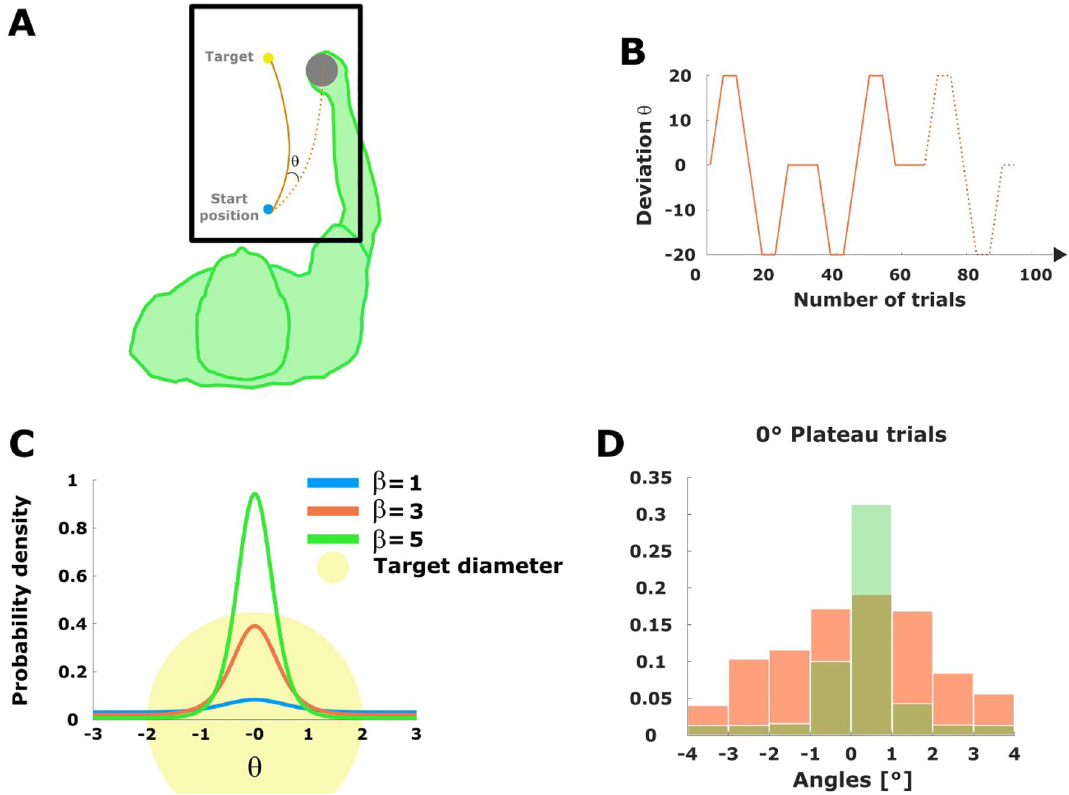
Figure 1. ( A ) Schematic representation of an experimental trial with deviation angle θ . The dotted line represents the participant’s hand movement and the continuous line represents the rotated movement observed on the screen. ( B ) Experimental protocol. The continuous line represents the deviation angles θ imposed during one experimental cycle, where trials 1 to 25 constitute the forward process and trials 34 to 58 constitute the backward process. The dotted line represents the beginning of the next cycle. ( C ) Illustration of the equilibrium distributions (2) with b , θ n = 0 resulting from the exponential quadratic error (1) and, respectively, β = 1, 1.5, 2 . The shaded area represents the target, which tolerates, at most, an error of 2 ◦ . ( D ) Comparison between the equilibrium distributions that we fit using the initial 100 trials (before participants experience any perturbation) and participants’ performance in the washout plateaus between cycles (the sequence of trials with θ = 0 that separate forward and backward protocol), to check whether participants equilibrate between cycles, as required by the fluctuation theorem. Red shows the normalized error histogram for the in-between plateaus exemplarily for participant 7, green shows the histogram of the fitted equilibrium distribution for the initial block of 100 trials of the same participant. The comparison for all other participants can be found in Fig.